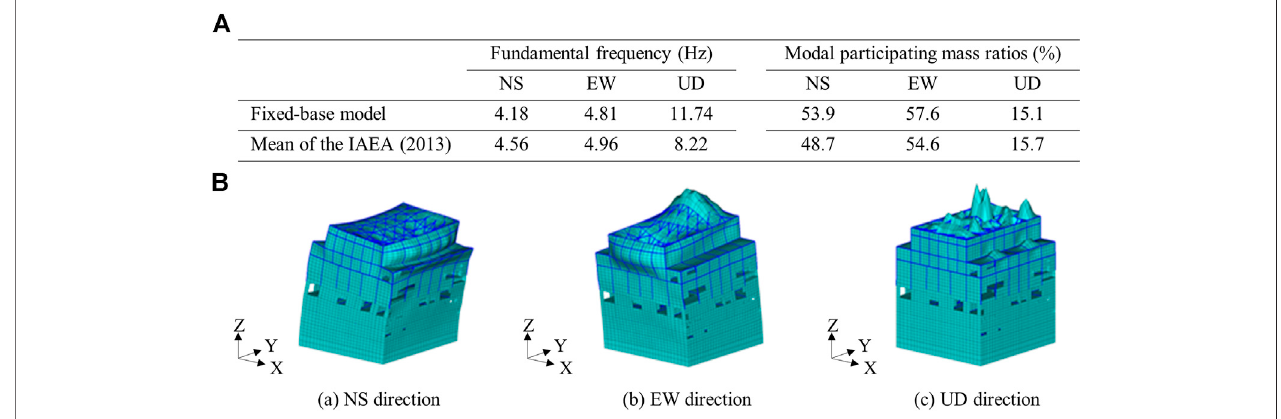
FIGURE 4 | Result of eigenvalue analyses for fi xed-base model. (A) Fundamental frequency and modal participating mass ratios. (B) Fundamental vibration mode shapes.